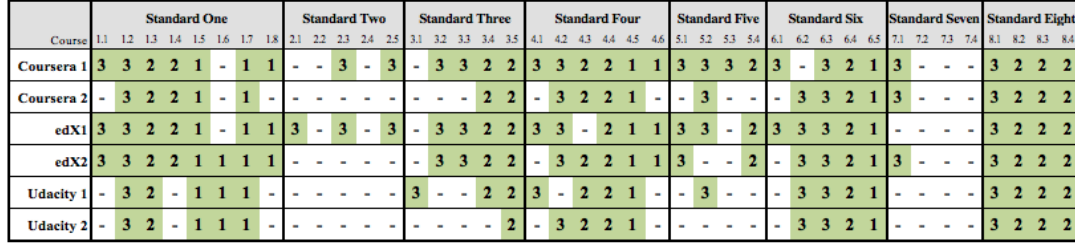
Figure 1. Individual ratings per